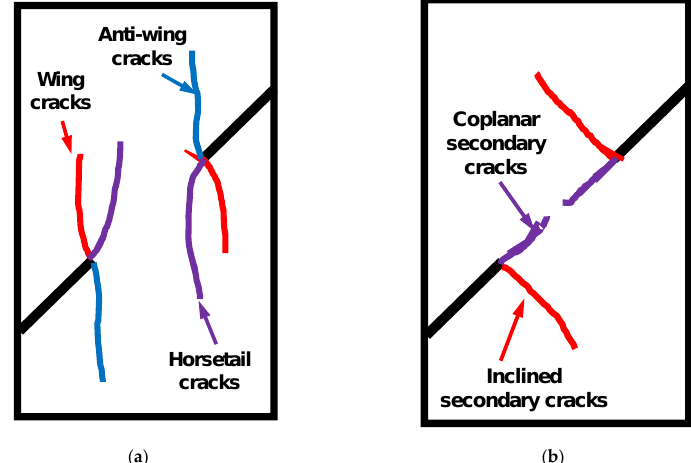
Figure 11. Five different kinds of crack appear in the present numerical simulations: ( a ) Tensile cracks and ( b ) shear cracks.